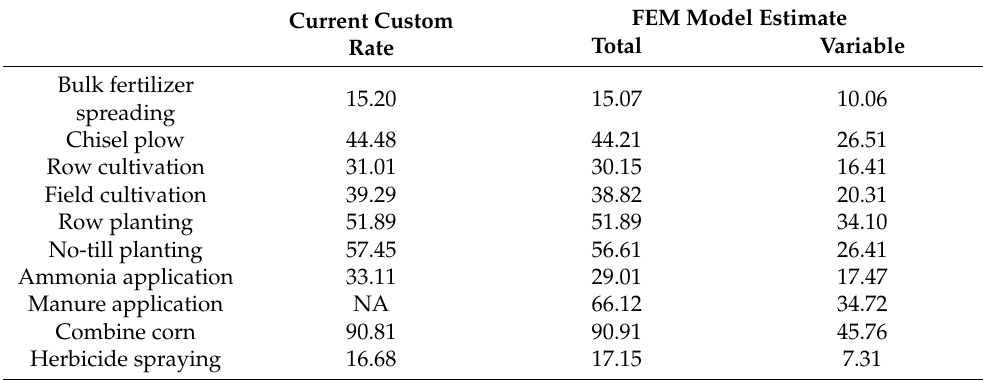
Table 4. Costs of simulated field operations and corresponding custom rates: